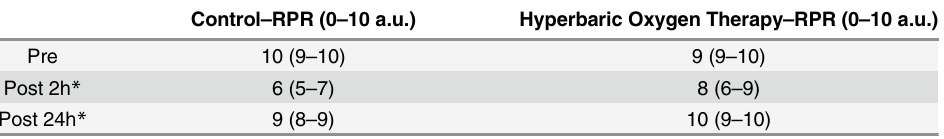
Table 2. Rating of perceived recovery (RPR) in Brazilian jiu-jitsu athletes prior to and following train- ing during for the control and hyperbaric oxygen therapy conditions (n = 11). Control – RPR (0 – 10